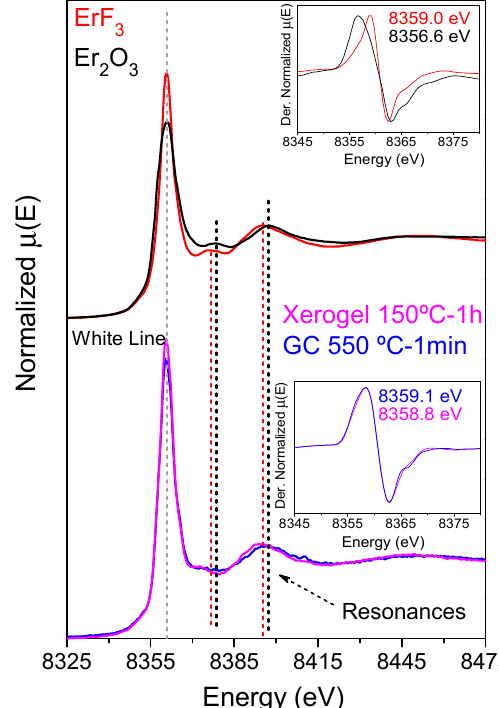
Figure 7. X-Ray absorption spectroscopy (XAS) spectra and derivatives (inset) of Er 2 O 3 and ErF 3 references in black and red, respectively (top), and of XAS spectra and derivatives (inset) of 80SiO 2 -20LaF 3 -0.5Er 3+ (TEOS-MTES) xerogel and GC thin film treated at 550 °C for 1 min, in pink and blue, respectively (bottom). The grey line indicates the white line and the red and black lines indicate resonance positions for ErF 3 and Er 2 O 3 , respectively.